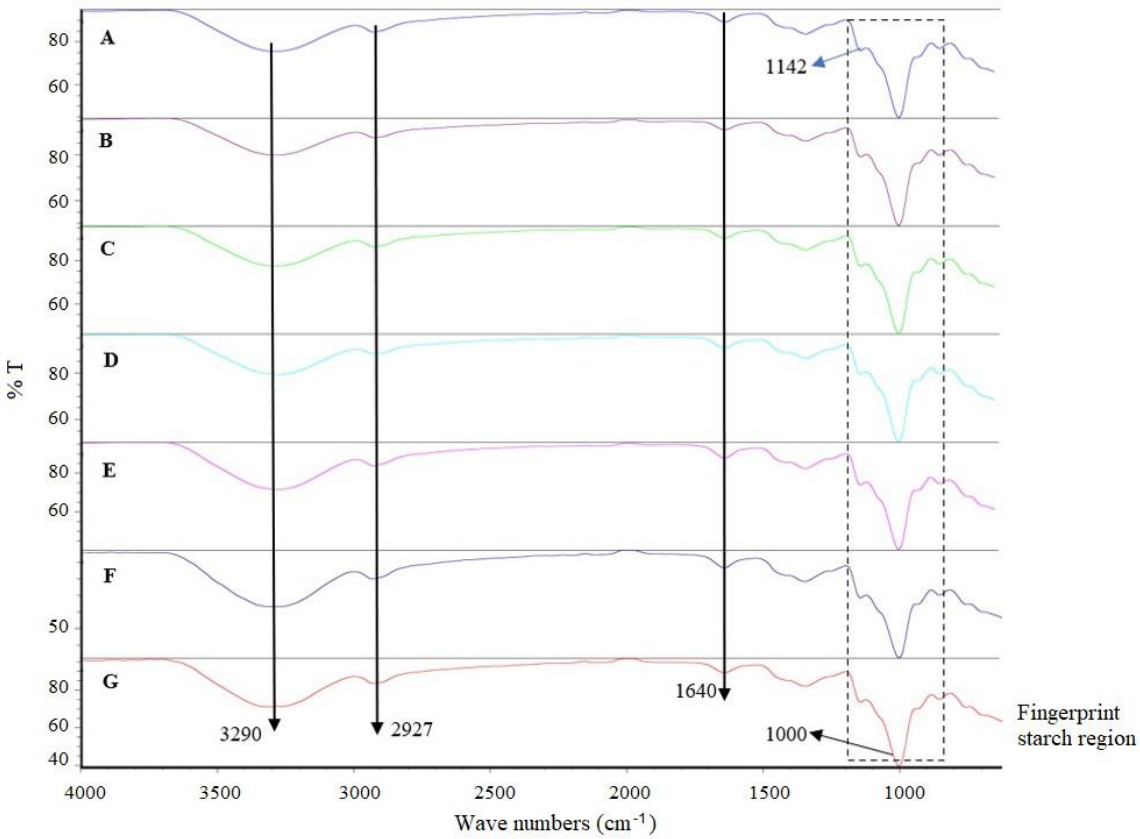
Figure 6. Fourier transform infrared spectroscopy of corn starch samples. Treatments T1 (A); T2 (B); T3 (C); T4 (D); T5 (E); T6 (F); and T7 (G).